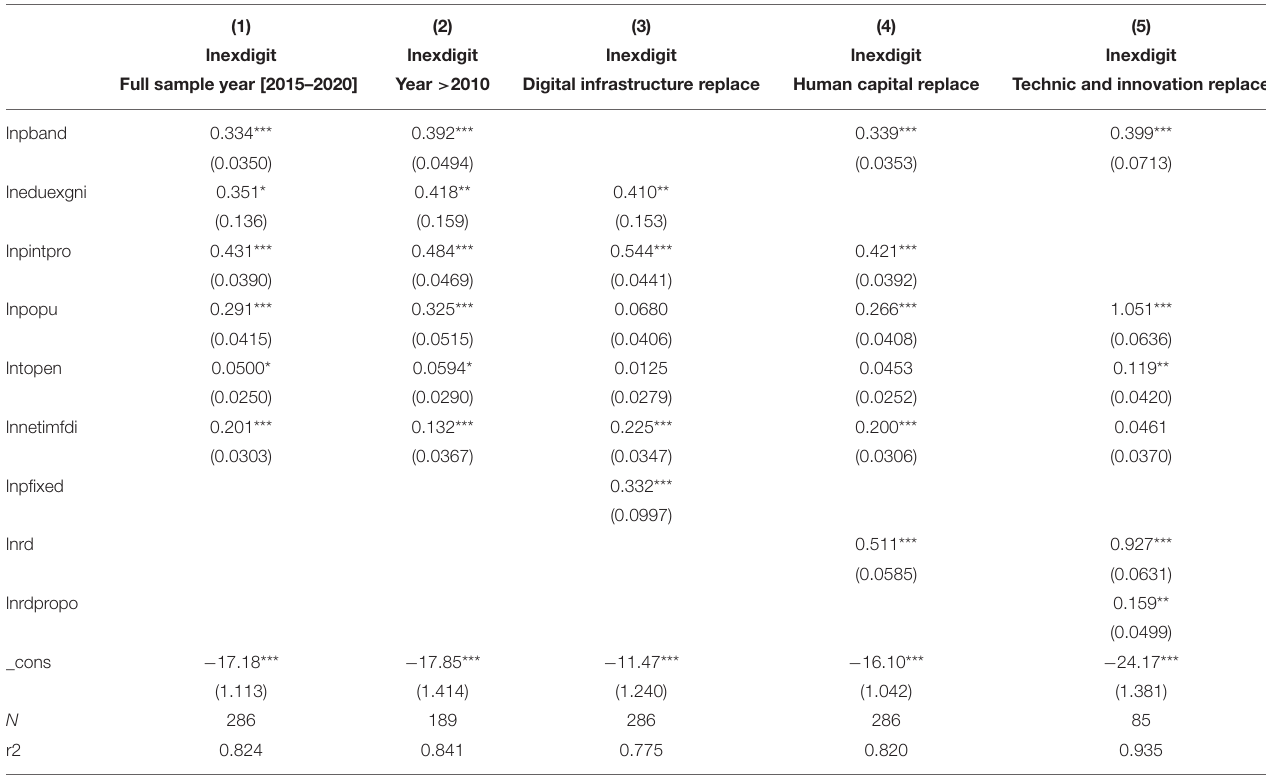
TABLE 3 | Model regression and robust test.